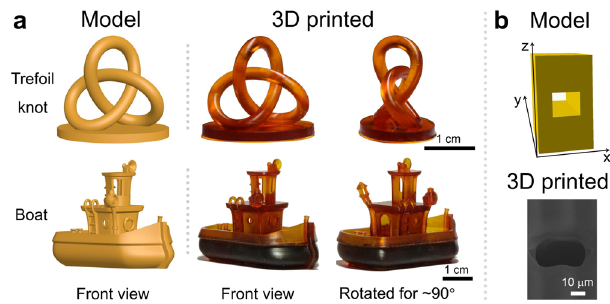
Fig. 5 Models and corresponding 3D-printed objects. a Pictures to show the 3D-printed trefoil knot and boat based on the KCD/TA system. The 3D- printed objects were rinsed with ethanol and postcured under UV fl ood (50 mW cm − 2 ) for 10 min. Color of the printed objects comes from KCD and KCD_2. b Model of the predesigned microscale hole and the corresponding SEM image based on the KCD/TA